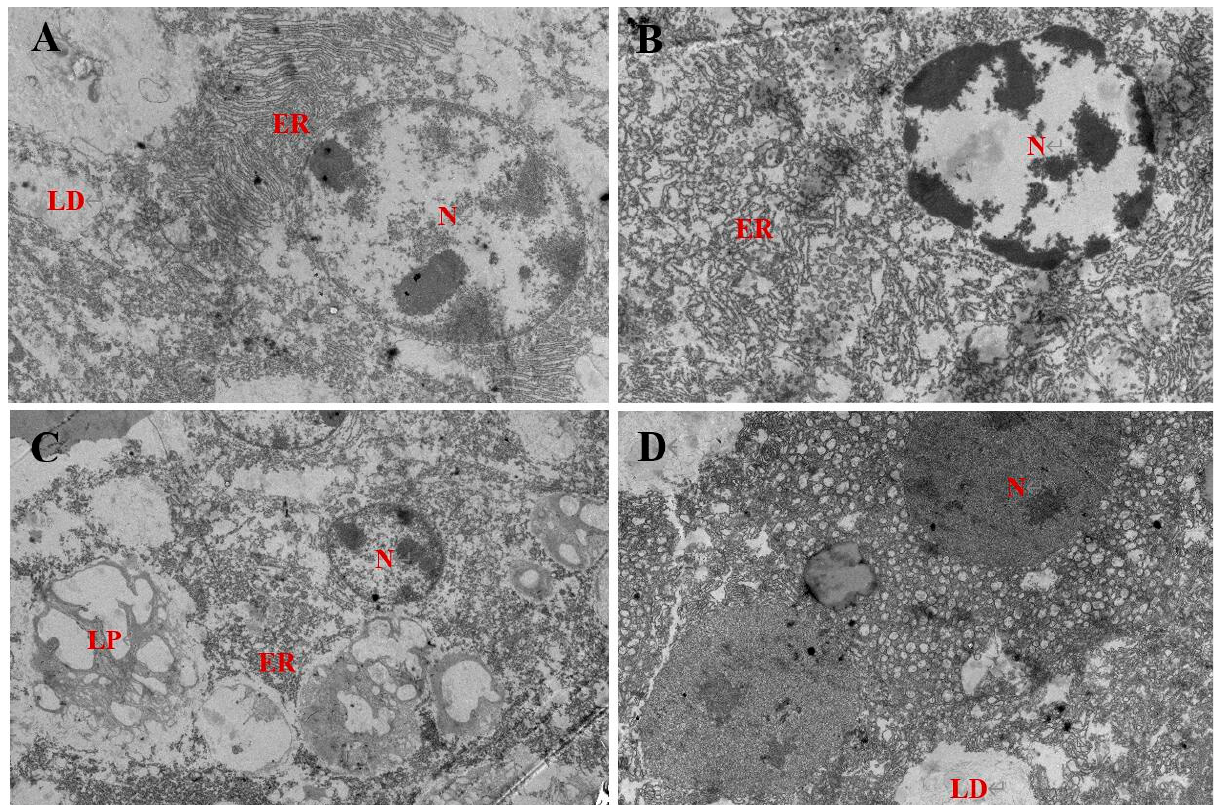
Figure 3. Transmission electron microscope images of Macrobrachium rosenbergii hepatocyte ultra- structure (2500×) fed with different dietary fat and VE levels. ( A ) prawns fed diet including 9% fat and 200 mg/kg VE; ( B ) prawns fed diet including 9% fat and 600 mg/kg VE; ( C ) prawns fed diet including 13% fat and 200 mg/kg VE; ( D ) prawns fed diet including 13% fat and 600 mg/kg VE. N: nucleus; LD: lipid droplet; ER, endoplasmic reticulum; LP, lipophagy.